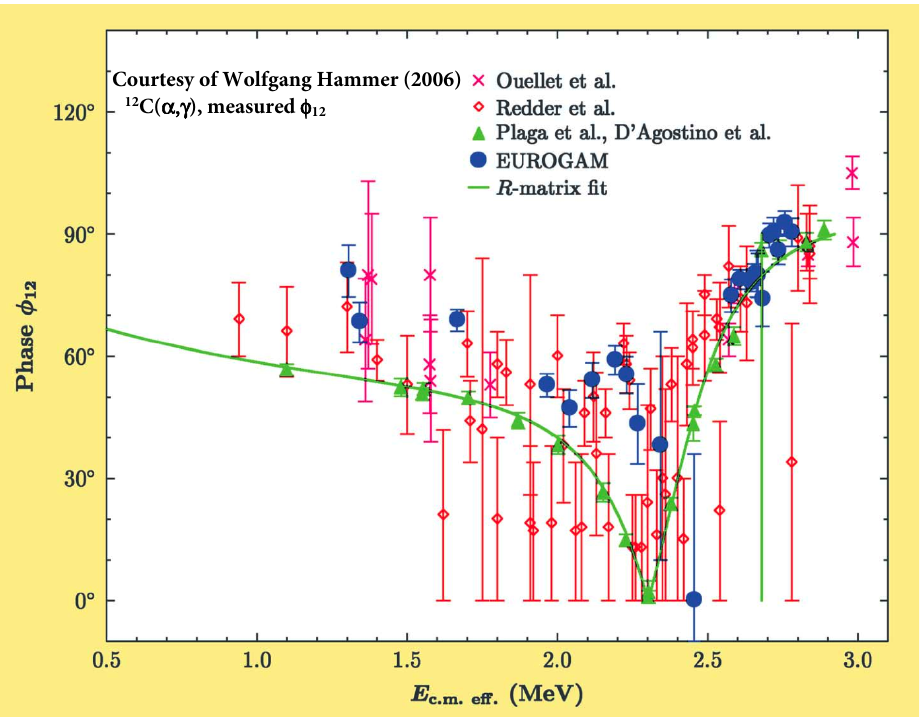
Fig 1: World data of measured f 12 compiled by Wolfgang Hammer (2006) [4] 2 The UConn-TUNL O-TPC